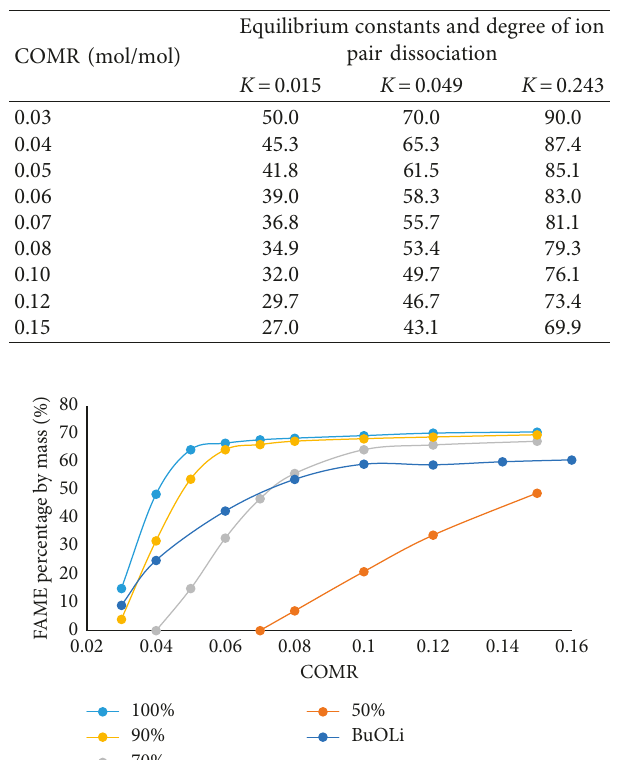
Table 2: The dependence of the degree of ion pair dissociation on the COMR.